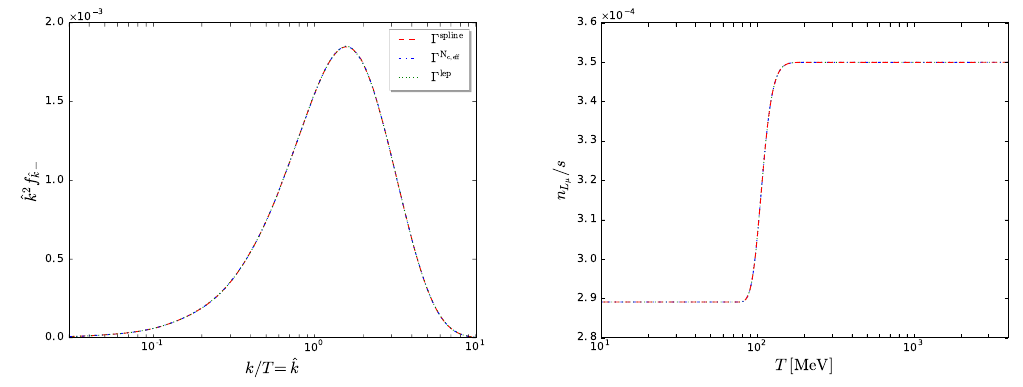
Figure 3 . Same as (cid:12)gure 1 but with an initial lepton asymmetry tuned such that the sterile neutrino energy density gives the complete relic dark matter abundance, (cid:10) s = (cid:10) DM